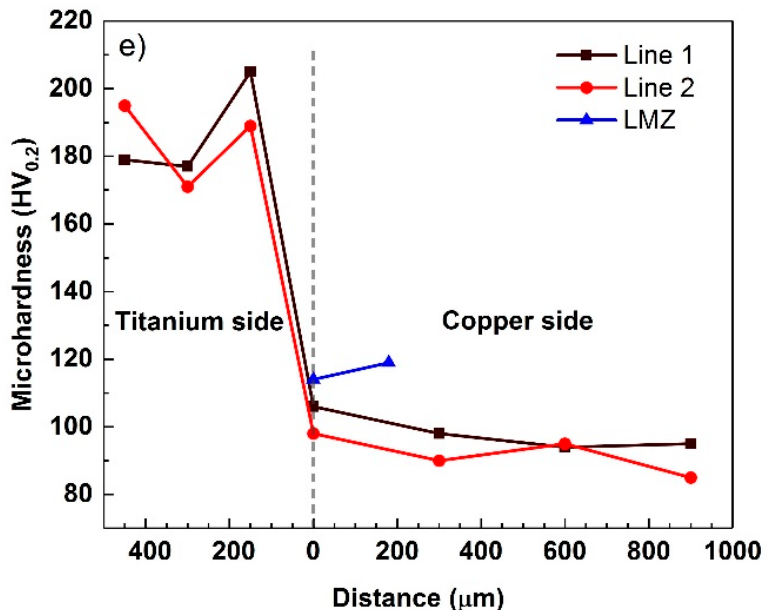
Figure 5. ( a ) Optical micrograph of microhardness distribution in the Ti-Cu bimetal, ( b ) on LMZ, ( c , d ) in the vicinity of the interface, and ( e ) micro-hardness profiles along a welded interface and LMZ.